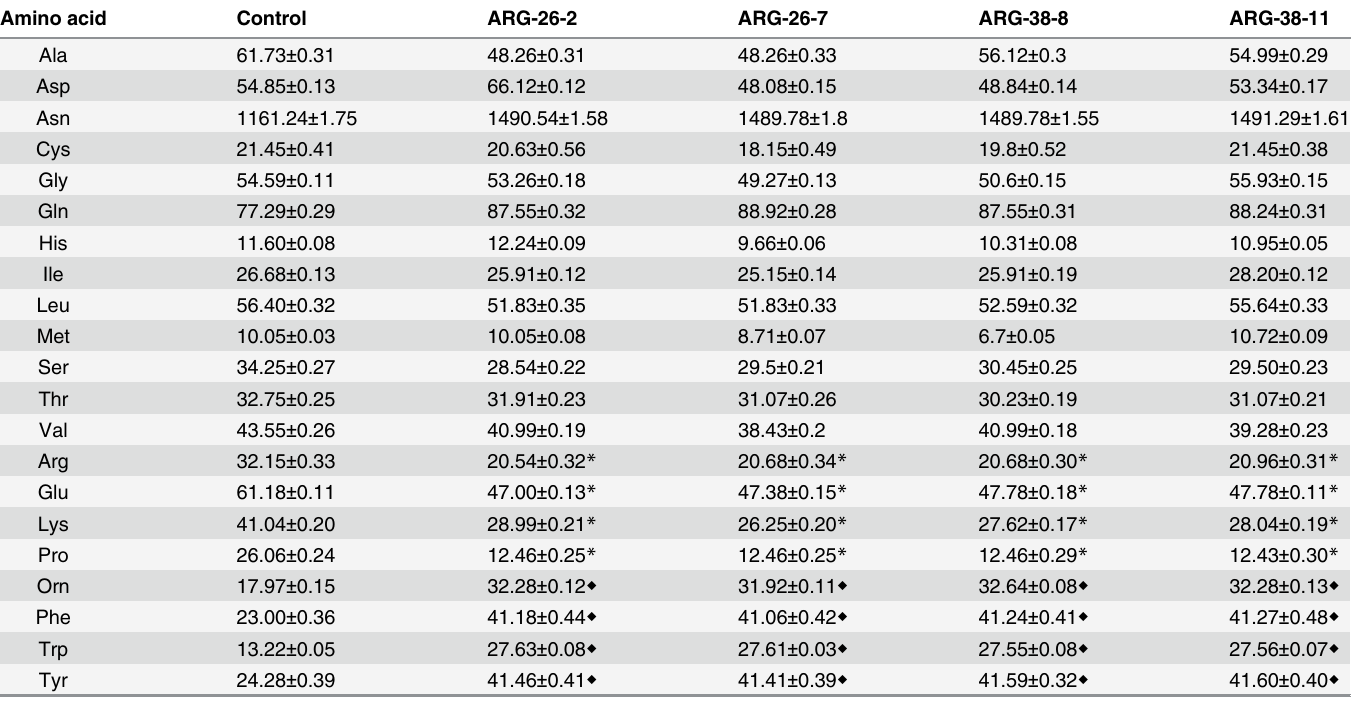
Table 1. Concentrations of amino acids in the leaves of control and transgenic cotton plants. Amino